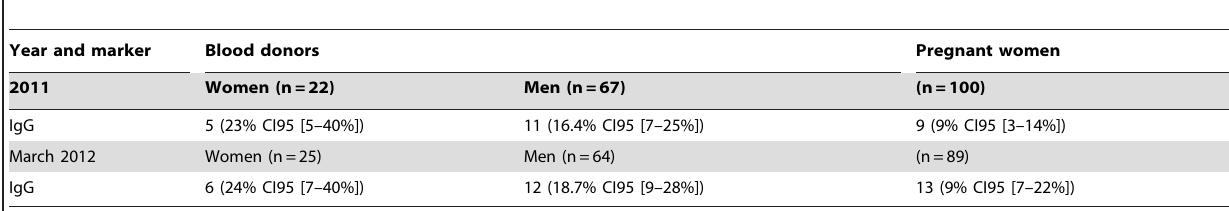
Table 2. Prevalence of anti-HEV IgG in pregnant women and blood donors per sampling period (Dia.Pro test).